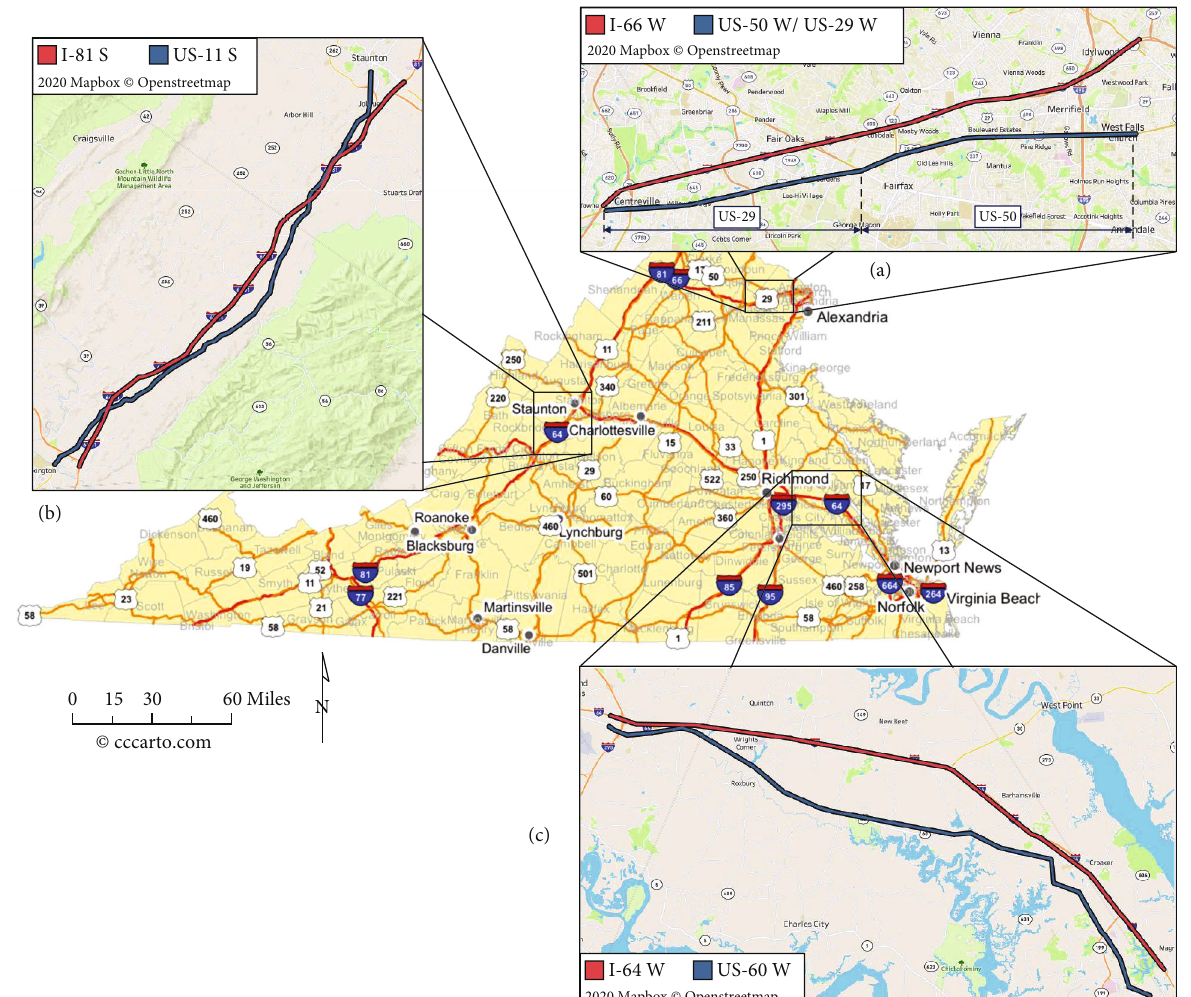
Figure 4: Case Study Locations across the Commonwealth of Virginia (Developed Using Tools in CHUBB Custom Cartography, [49]): (a) I-66 and US-50 Westbound, (b) I-81 and US-11 Southbound, and (c) I-64 and US-60 Westbound